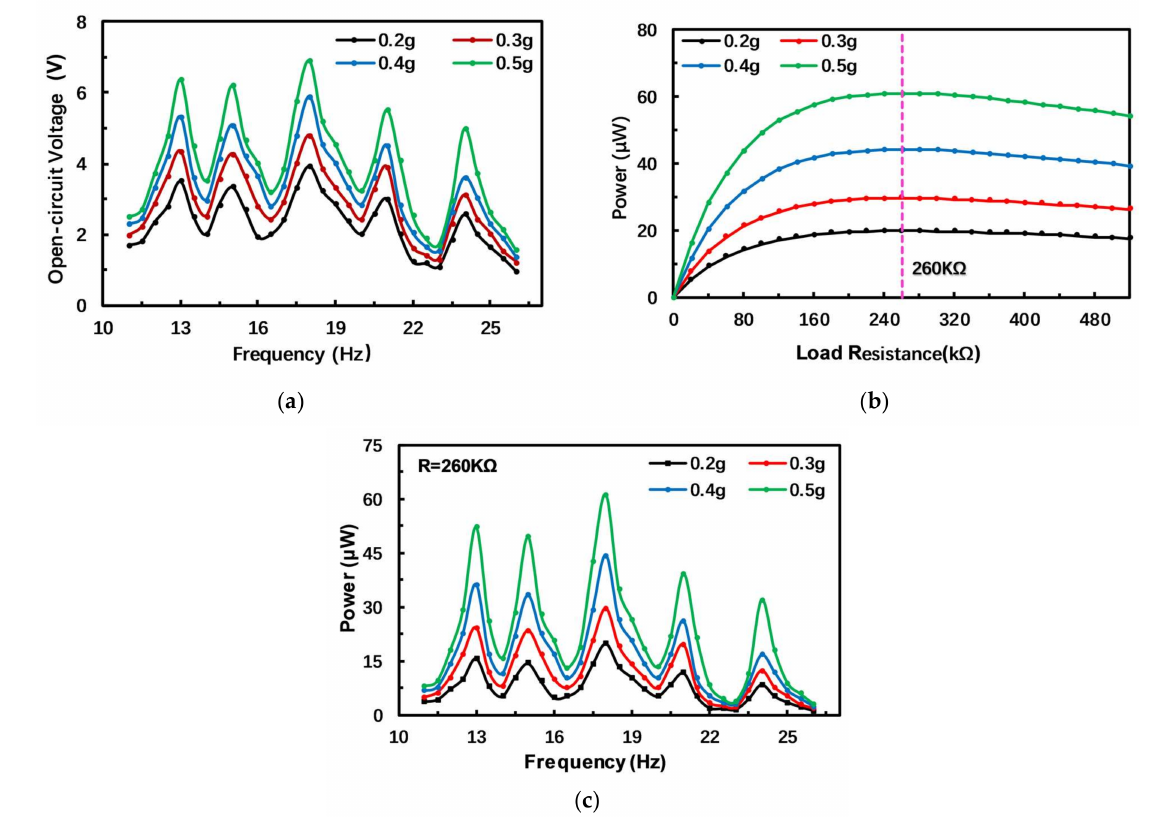
Figure 7. Experimental results of output characteristics of the PEH. ( a ) Measured frequency response of open-circuit voltage; ( b ) Measured results of output power against load resistance under different acceleration amplitudes; ( c ) Measured results of frequency response of output